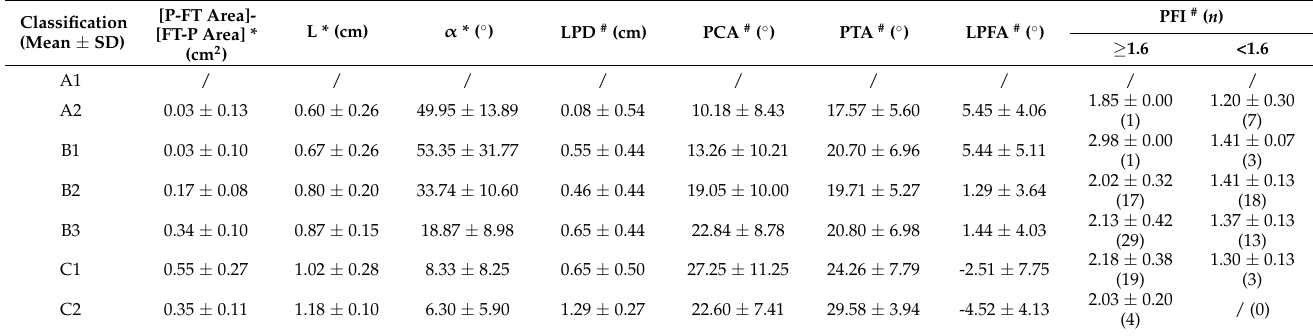
Figure 5. ( A ) Age distribution. ( B ) Graph showing feet distance before and after surgery. ( C ) Graph showing Q-angle before and after surgery. ( D ) Graph showing the knee flexion angle when the patient squatted maximally before and after surgery. ( E ) Graph showing the hip flexion angle when the patient squatted maximally before and after surgery. These four indicators exhibited statistically significant differences when compared before and after surgery (non-parametric test, p = 0.000). International classification: classification of Ye et al. [1]. Table 2. Measurement results of patellofemoral parameters in knee CT ( n =